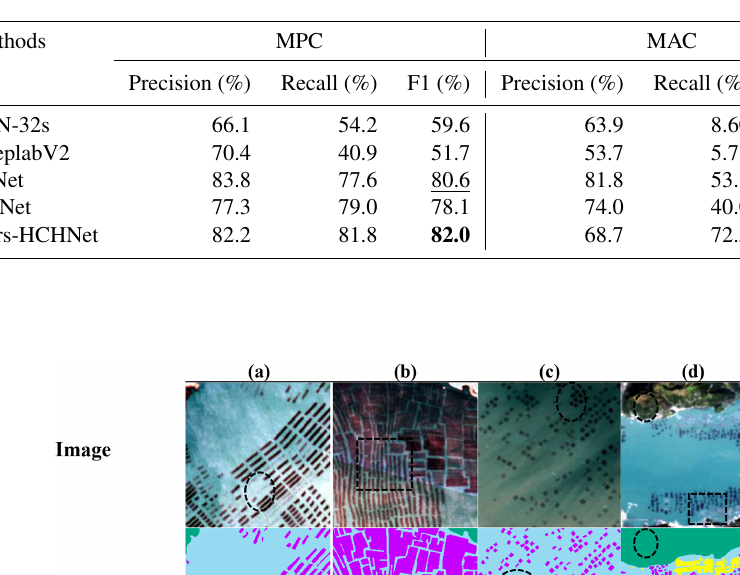
Table 4. Quantitative comparison of MPC and MAC areas between our method and other methods, where the best accuracy values are in bold (%), and the second best are underlined.